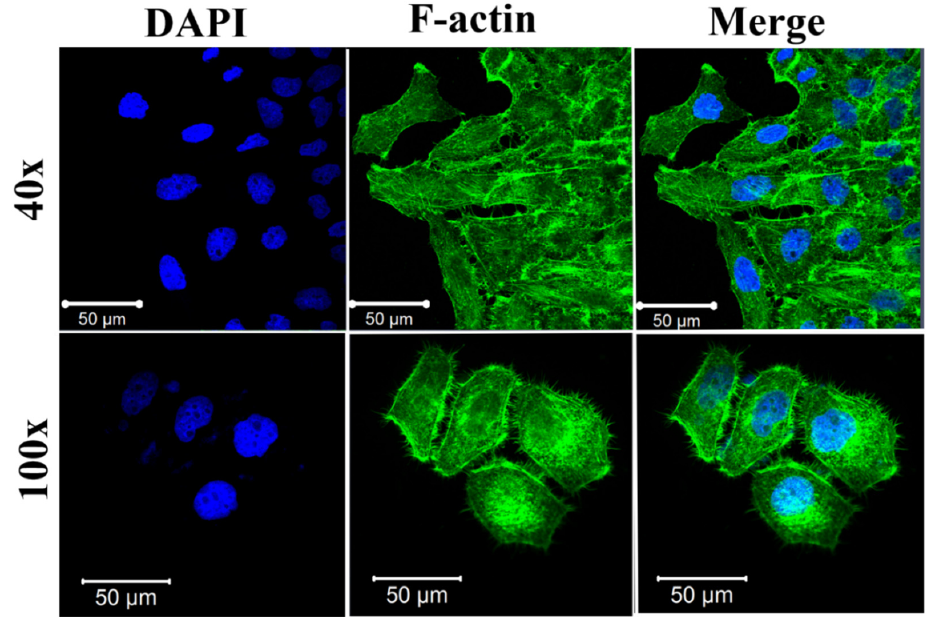
Figure 4. Immunofluorescent images of HeLa cells cultured for 24 h on Lab-Tek. F-actin was stained by Alexa Fluor 488 Phalloidin (green) and cell nuclei were stained by DAPI (blue), respectively. Confocal laser scanning microscopes (CLSM) with a water immersion objective Zeiss 40×/NA 1.2 were applied.